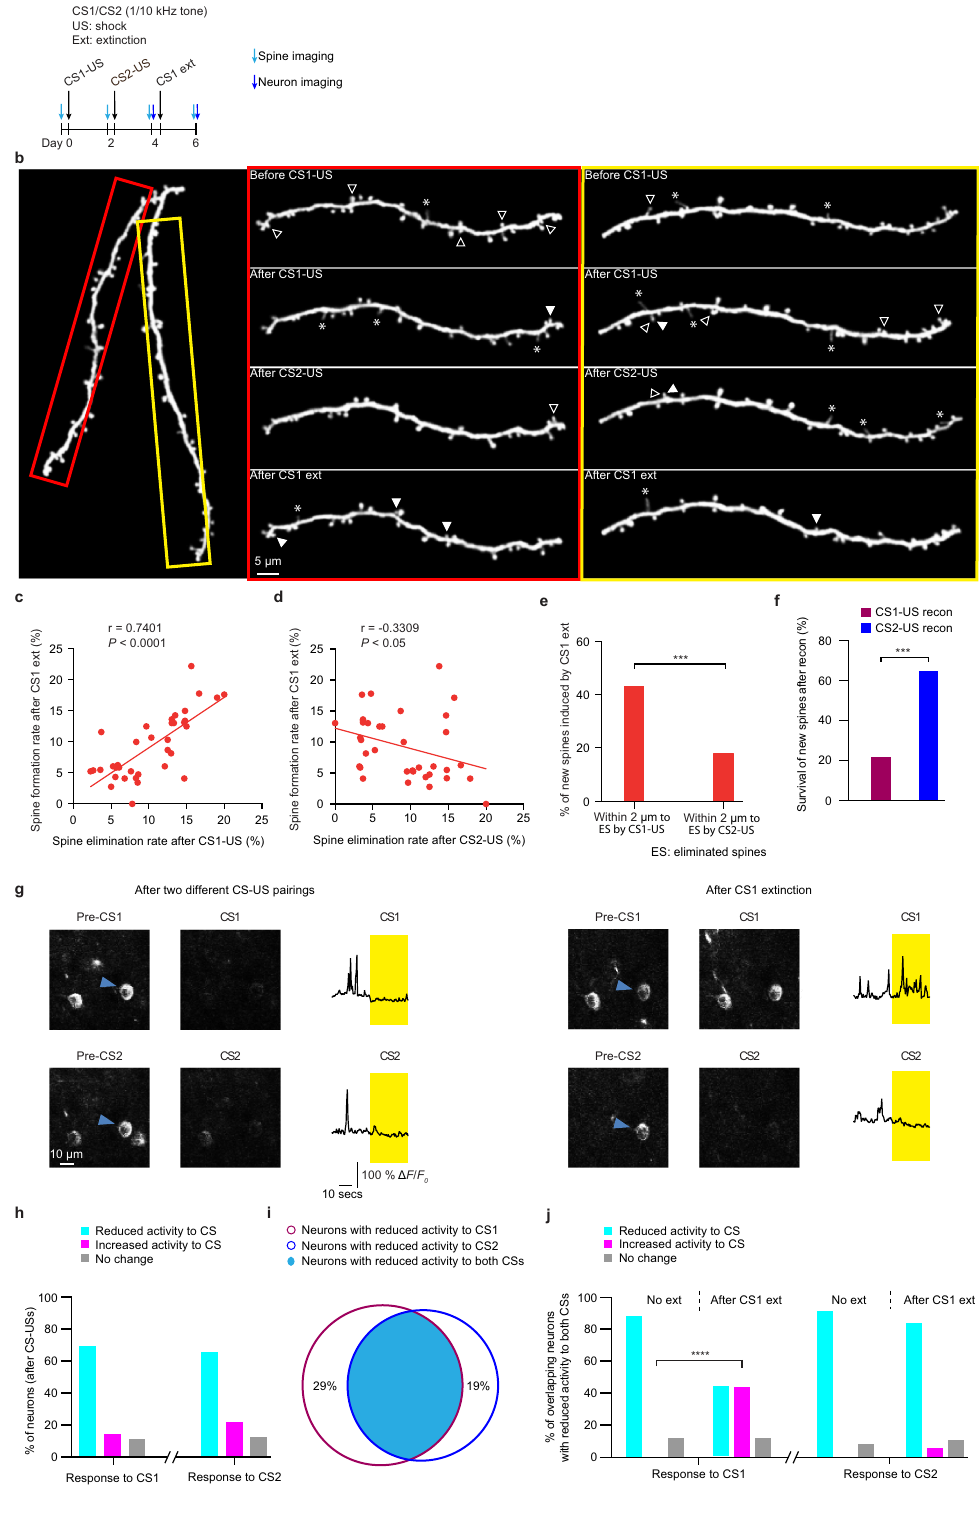
newly-formed spines from 7 mice). Without extinction, only a small fraction (15.8% and 10.5%) of newly-formed spines were located within 2 µ m of spines eliminated by CS2-US pairing or by CS3-US pairing (Fig. 6d; P < 0.05 respectively, chi-square test, compared to that in the extinction group; n =19 newly-formed spines from 5 mice).